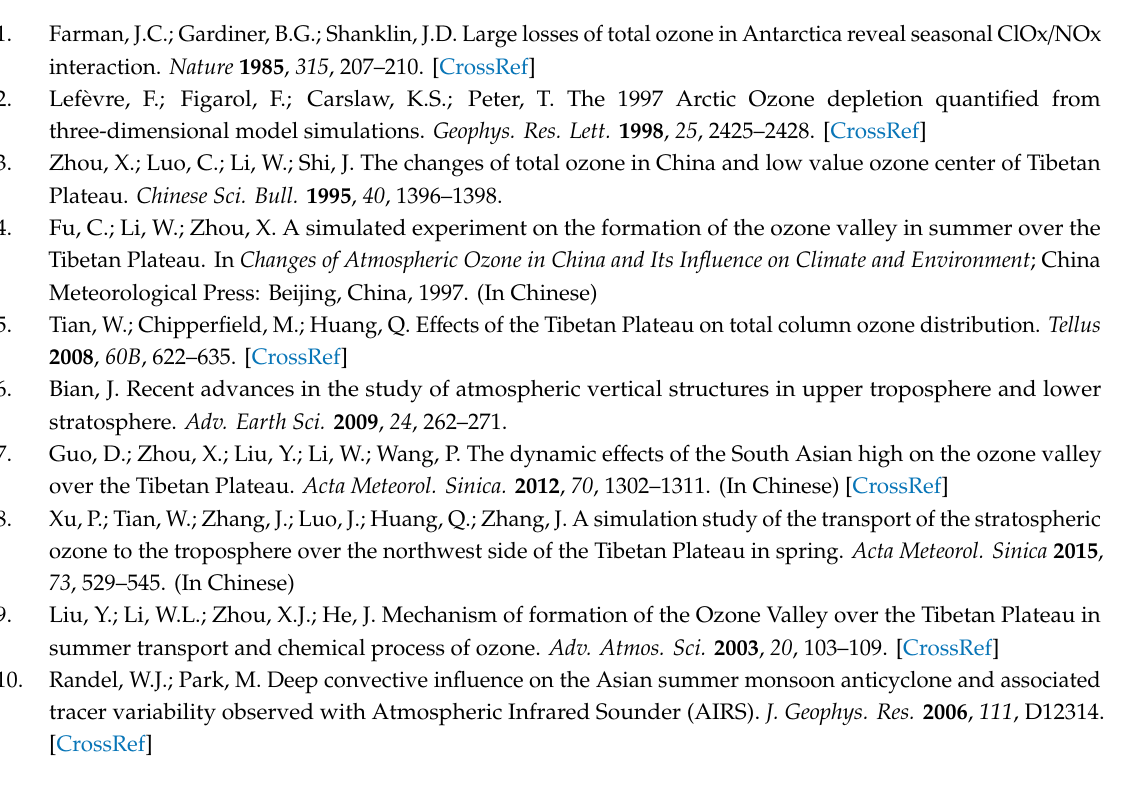
Table S1: Photochemical reactions, Table S2: Thermochemical